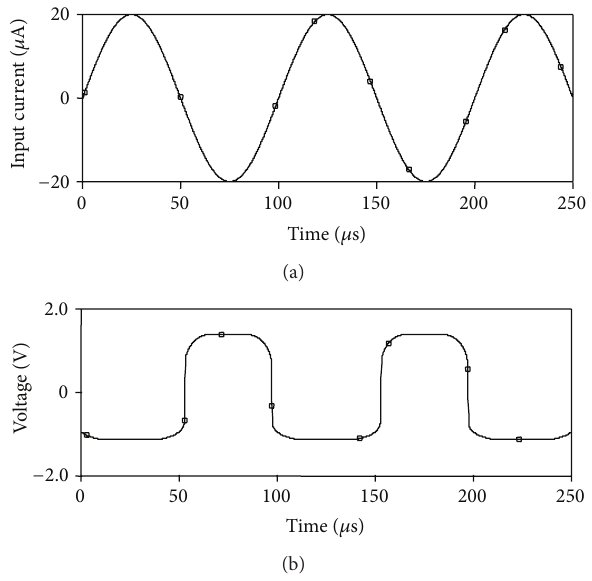
Figure 4: Time domain response of input current and 𝑥− port voltage.